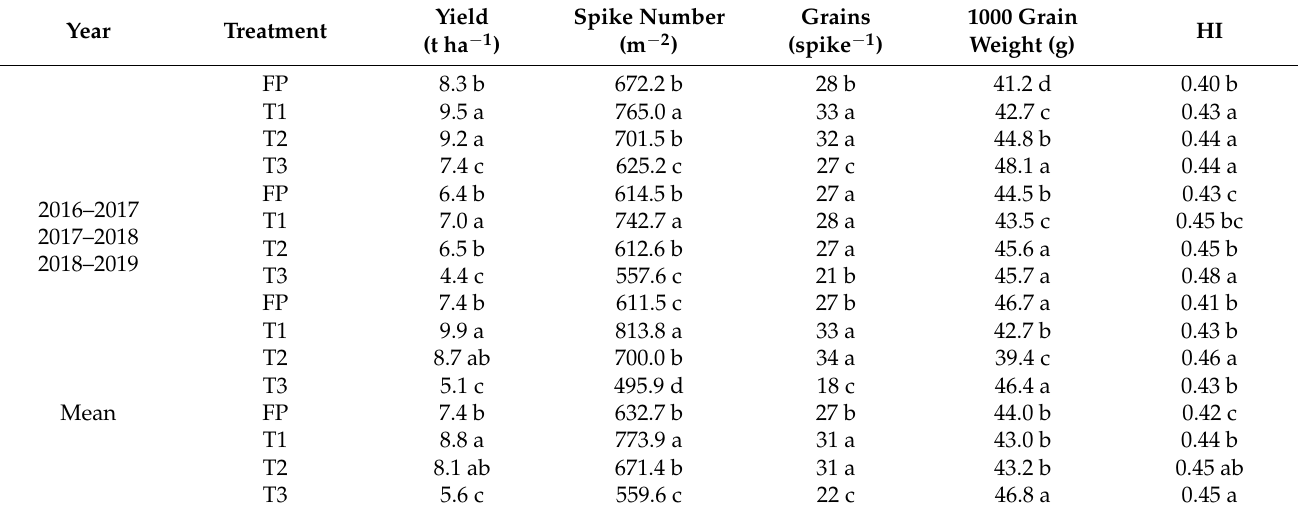
Values within columns followed by the different letters are statistically significant at p < 0.05 level among treatments.